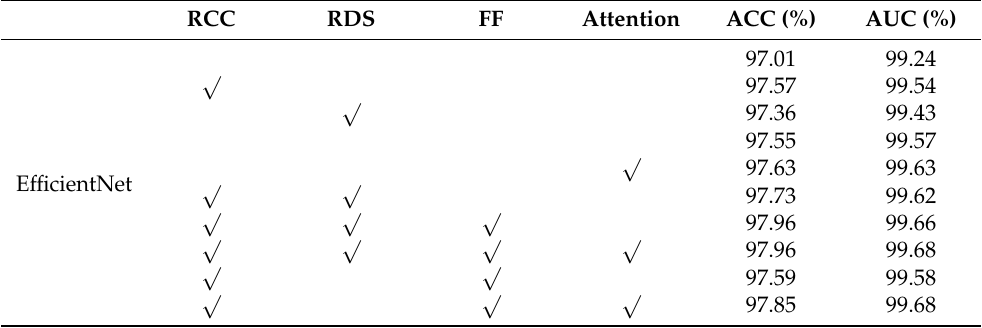
Table 2. Classification performance comparison of EfficientNet with various strategies of the RPCam testing